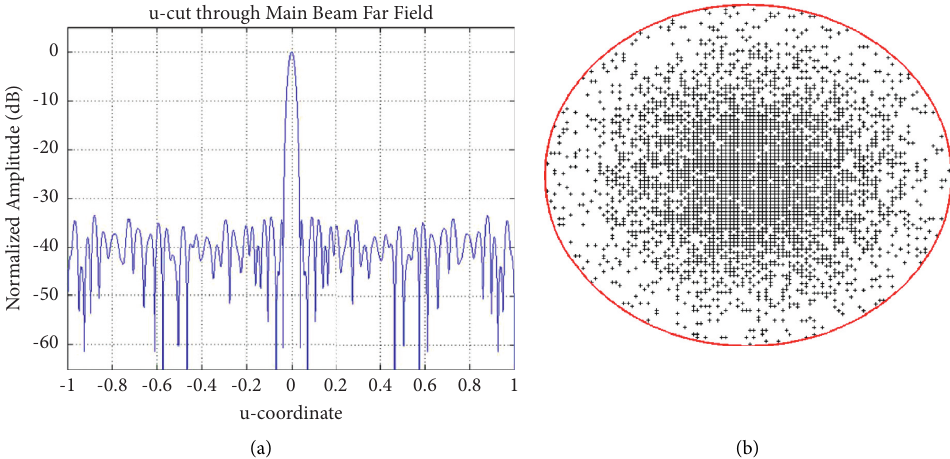
Figure 3: A thinned circular aperture array having a diameter of 50 λ and based on a 0.5 λ spaced square grid with 40% FL. The IFTsynthesis results [29]: (a) pattern cut; (b) array architecture with 3116 ON-elements across the aperture.